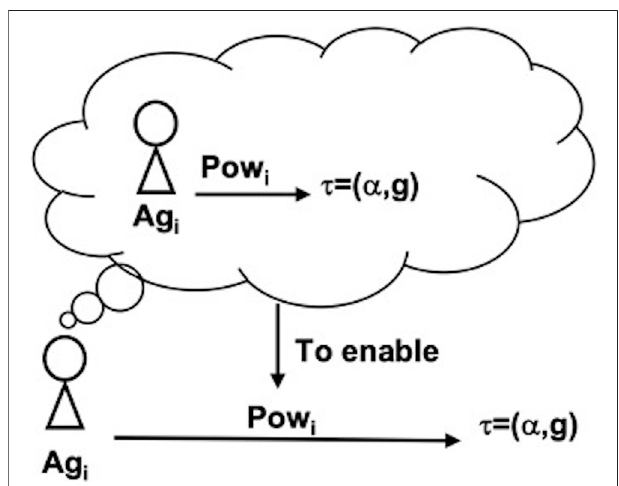
FIGURE1| Ag i toreallyhavethepower toaccomplishthetask τ ,itmust believethatitpossessesthatpower.Thisbeliefactuallyenablestherealpower of it to